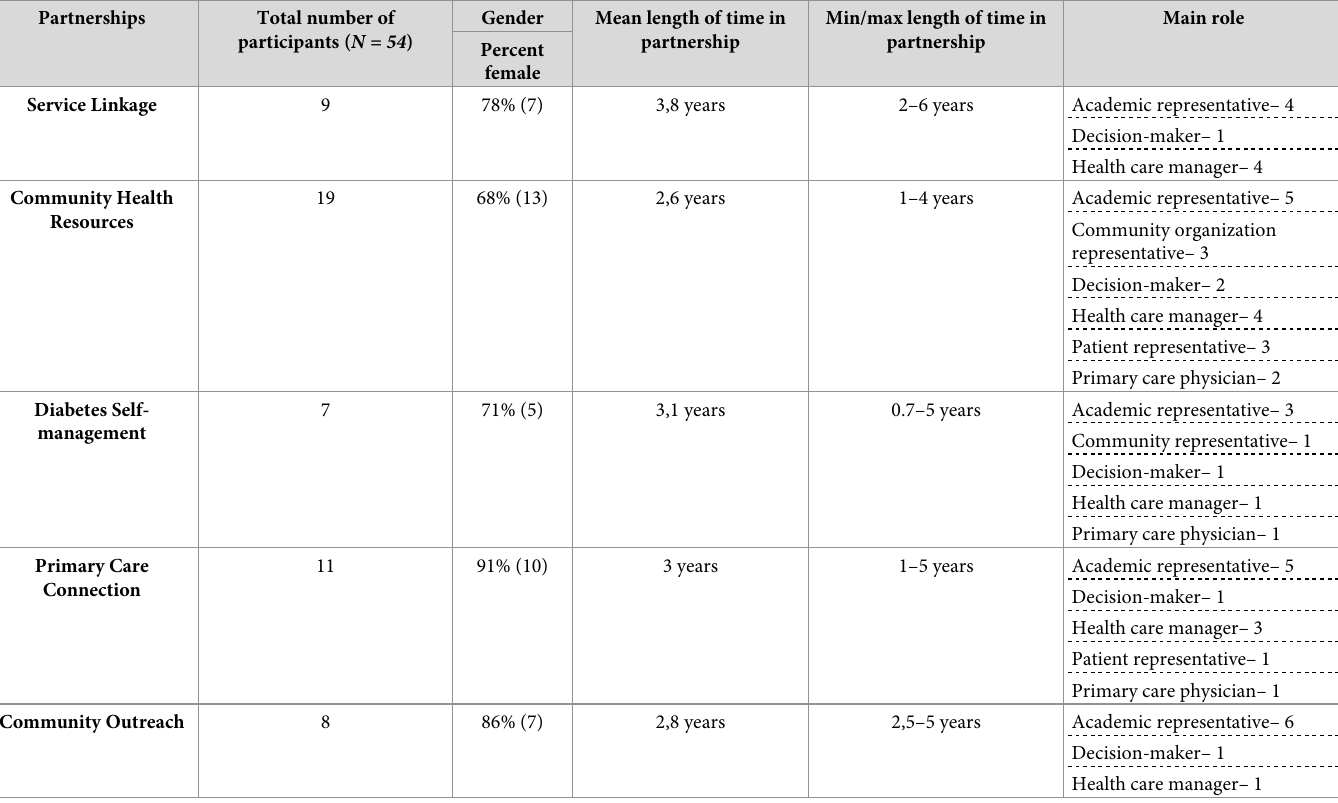
Table 2. Study sample characteristics per partnership ( N =